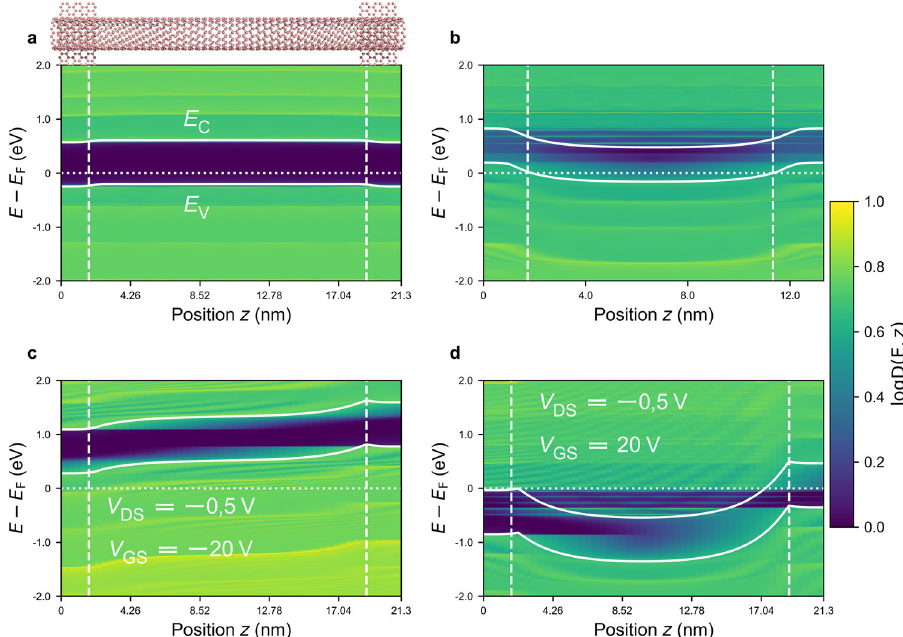
Fig. 4 Band diagram and local density of states along carbon nanotube axis of the all-carbon transistor. a Local density of states D ( E , z ) plotted as a 2D- colormap over the Energy E (with respect to the Fermi level E F ) and the position along the tube z . The conduction- ( E C ) and valence- ( E V ) band-edges of the all-carbon transistor at zero drain-source ( V DS = 0) and zero gate-source ( V GS = 0) voltage are plotted as white solid lines. The channel length is L = 17.0 nm, and the carbon nanotube-graphene overlap is semi-in fi nite ( L = ∞ ). The vertical white lines indicate the interfaces between the channel contact channel and contact regions. The similar work function of graphene and the carbon nanotube (CNT) causes a weak p-doping of the CNT in the contact regions. b Conventional CNT fi eld effect transistors with metallic (Pd) contacts: The CNT is strongly p-doped in the contact regions, causing Ohmic contacts for holes and a strong band bending. c Band bending and local DOS inside the device with applied drain-source ( V DS = − 0.5 V) and gate-source voltage ( V GS = − 20 V). The Fermi-level in the contact region is not pinned between the bandgap of the CNT. Instead, the CNT undergoes electrostatic p-doping in the contact region, caused by the negative gate-source voltage. We explain the low gate ef fi ciency, which causes the doping-induced screening of the electrostatic fi eld. d The transistor is in the on-state with opposite polarity V GS = 20 V (n-polarity). Here the CNT in the contact regions is n-doped (caused by a positive V GS ). The scale bar shows the logarithmic spectral function log D ð E ; z Þ normalized to the range of values between 0 and 1.